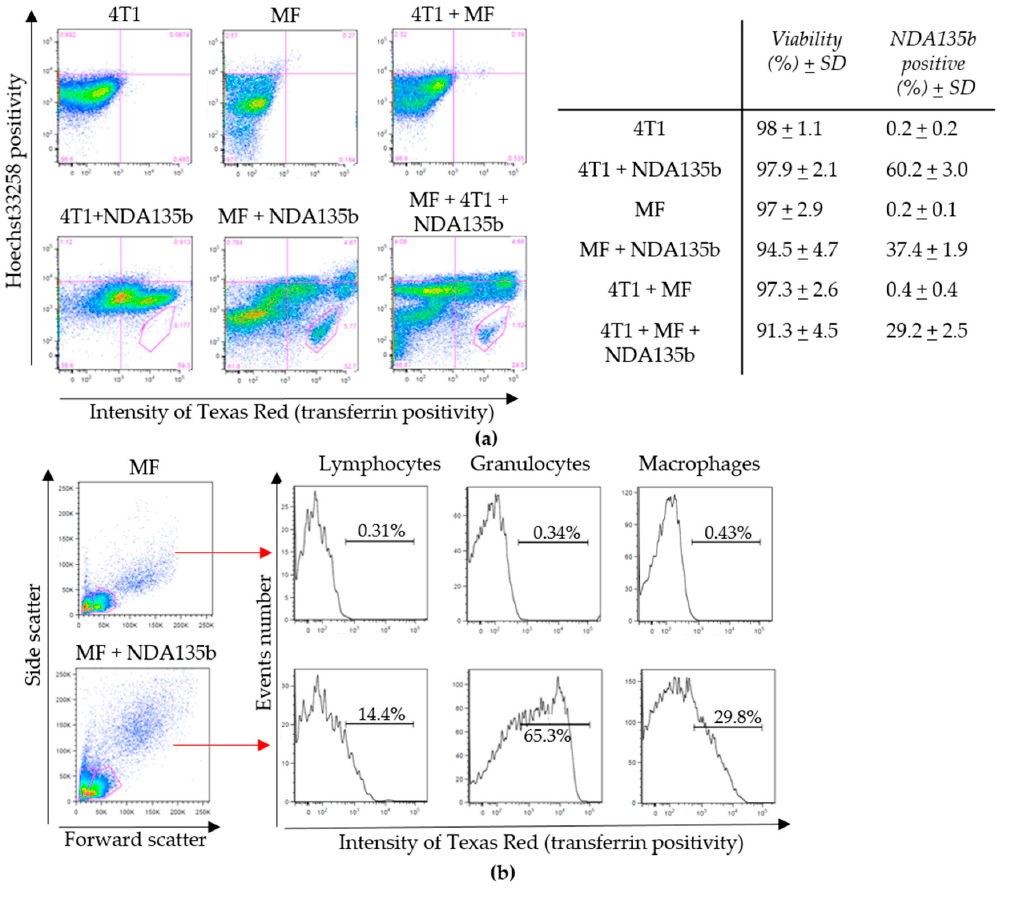
Figure 4. Targeting of 4T1 spheroids by functionalized nanodiamonds within a mixed 3D co-culture with peritoneal lavage cells (MF) imitating basic tumor microenvironment: ( a ) Uptake of targeted nanodiamond complex NDA135b by particular cells within a spheroid MF co-culture. The average percentage of positivity (and standard deviation) are listed on the right; ( b ) gating of live cells within the peritoneal lavage sample with or without stimulation by NDA135b (left) and detection of NDA135b in individual populations (right).